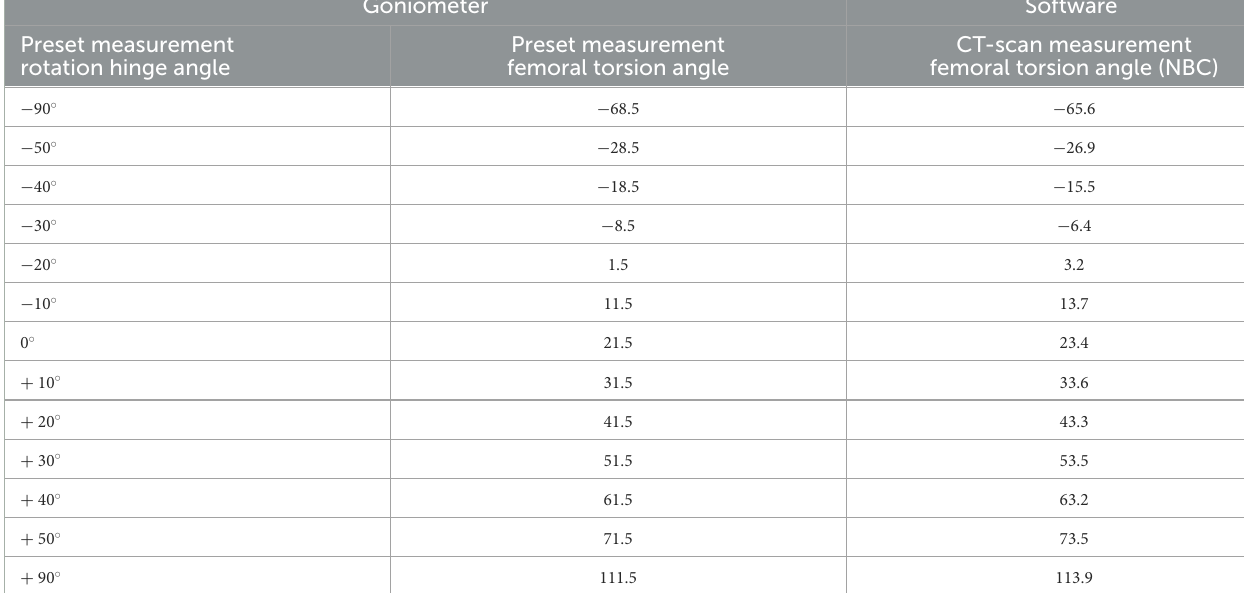
TABLE 1 Results of the femoral neck version angle measurements in the femoral torsion model. Comparison between goniometer and CT-scan based software measurements of the femoral neck version angle in a canine femoral torsional deformity model in physiological (0 ◦ /21.5 ◦ ) and abnormal preset diaphyseal torsion